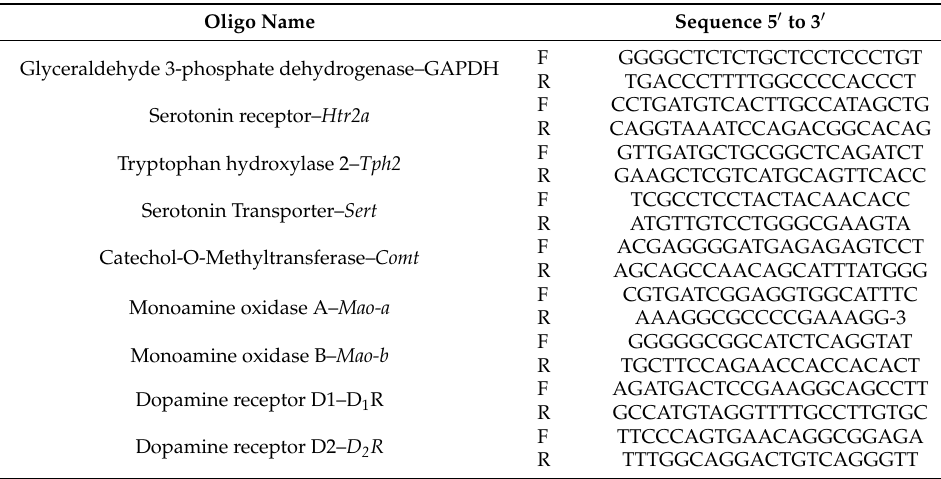
Table 2. List of primers used in